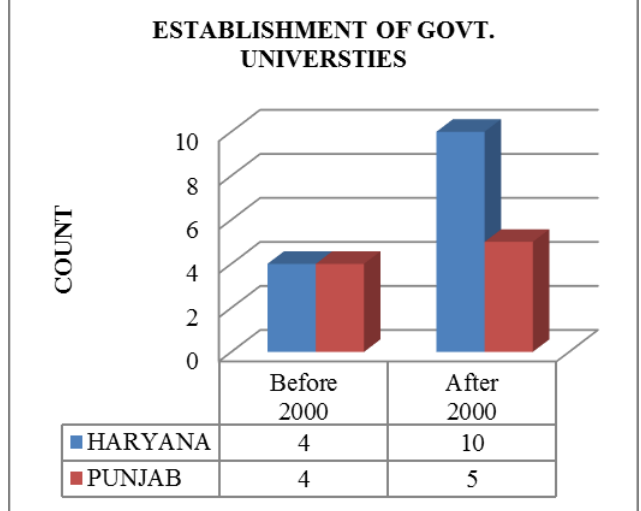
Figure 1. Government Universities in Haryana and Punjab